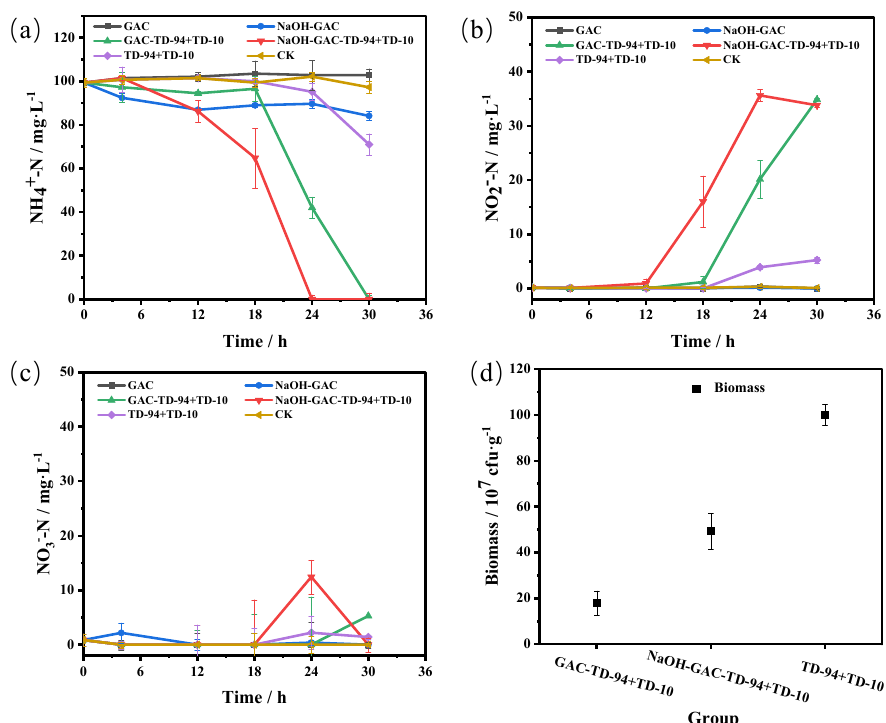
Figure 3. Ammonia nitrogen removal capacity of free and immobilized cells. ( a ) NH 4+ -N concentration, ( b ) NO 2- -N concentration, ( c ) NO 3- -N concentration, ( d ) biomass. (TD-94 represents Alcaligenes sp. TD-94; TD-10 represents Paracoccus sp. TD-10; TD-94+TD-10 represents Alcaligenes sp. TD-94 and Paracoccus sp. TD-10).